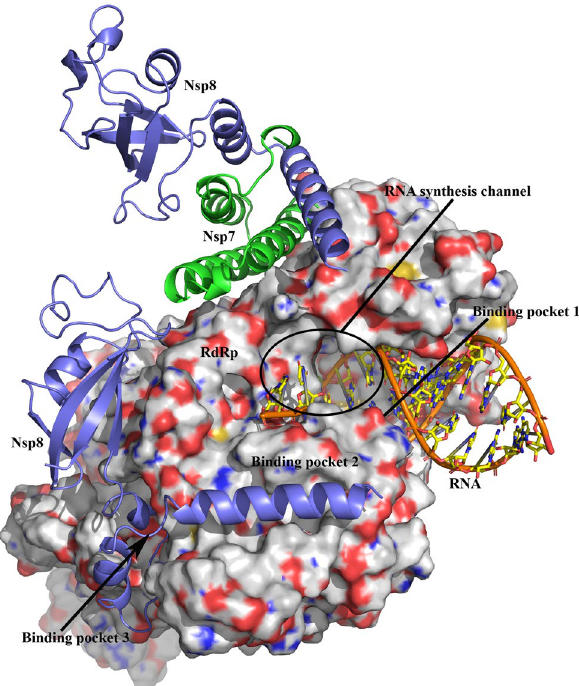
Figure 2. Structure of SARS-CoV 2 RdRp (surface presentation) in complex with Nsp7 (in green), Nsp8 (in purple) co-factors and RNA molecule (stick model). In one case RdRp directly interacts with Nsp8, in other it binds to heterodimer of Nsp7 and Nsp8. Pocket 1 locates in RNA synthesis channel, pockets 2 and 3 locate in direct binding interface between RdRp and Nsp8.